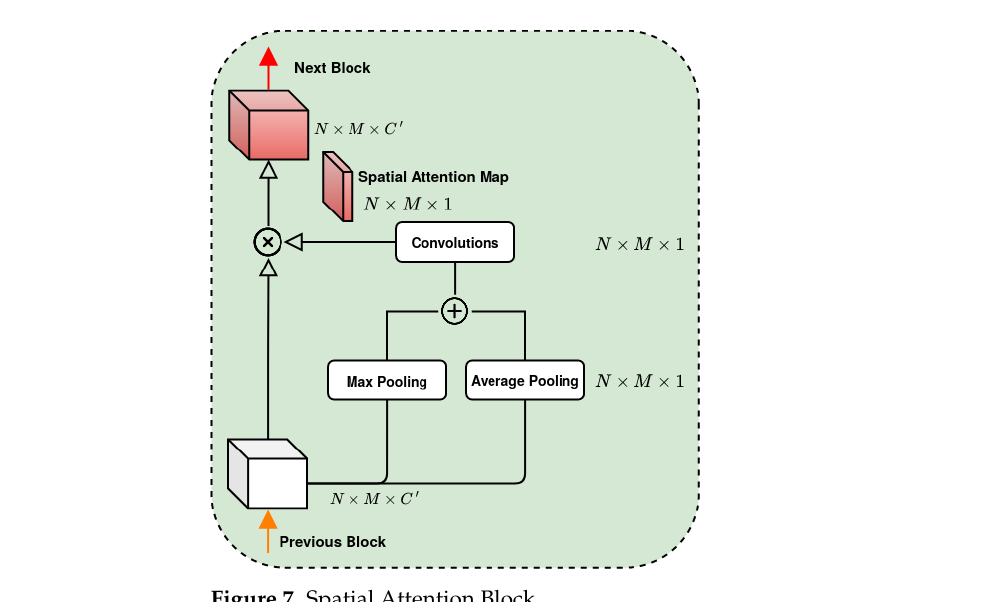
Figure 7. Spatial Attention